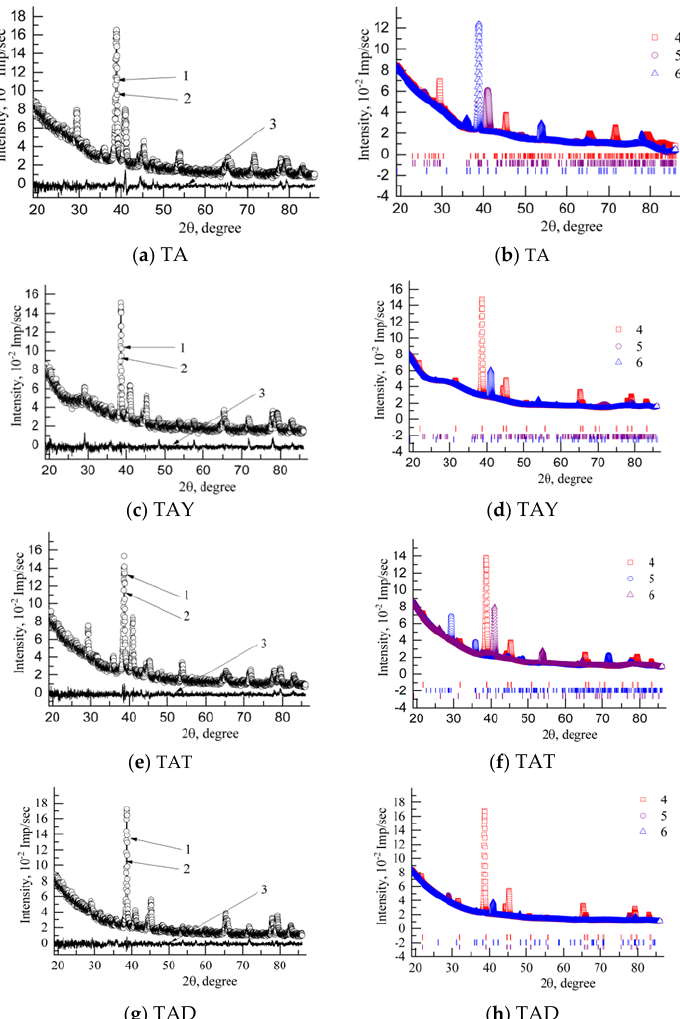
Figure 2. Diffraction patterns of alloys TA( а,b ); TAY ( c,d ); TAT ( e,f ); TAD ( g,h ): 1—experiment, 2— Figure 2. Di ff raction patterns of alloys TA ( a , b ); TAY ( c , d ); TAT ( e , f ); TAD ( g , h ): 1—experiment, summary model intensity, 3—difference between intensities, 4–6—contributions to the integral intensity of 2—summary model intensity, 3—di ff erence between intensities, 4–6—contributions to the integral separate phases. intensity of separate